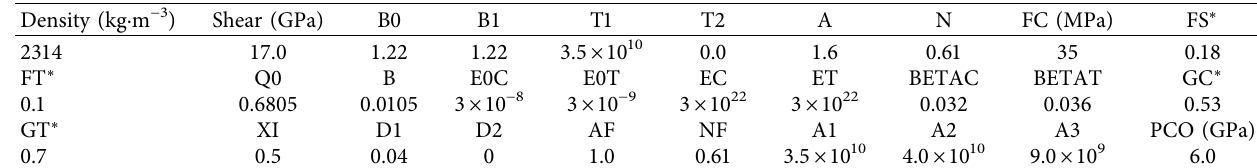
Table 4: Main parameters of the RHT constitutive model.